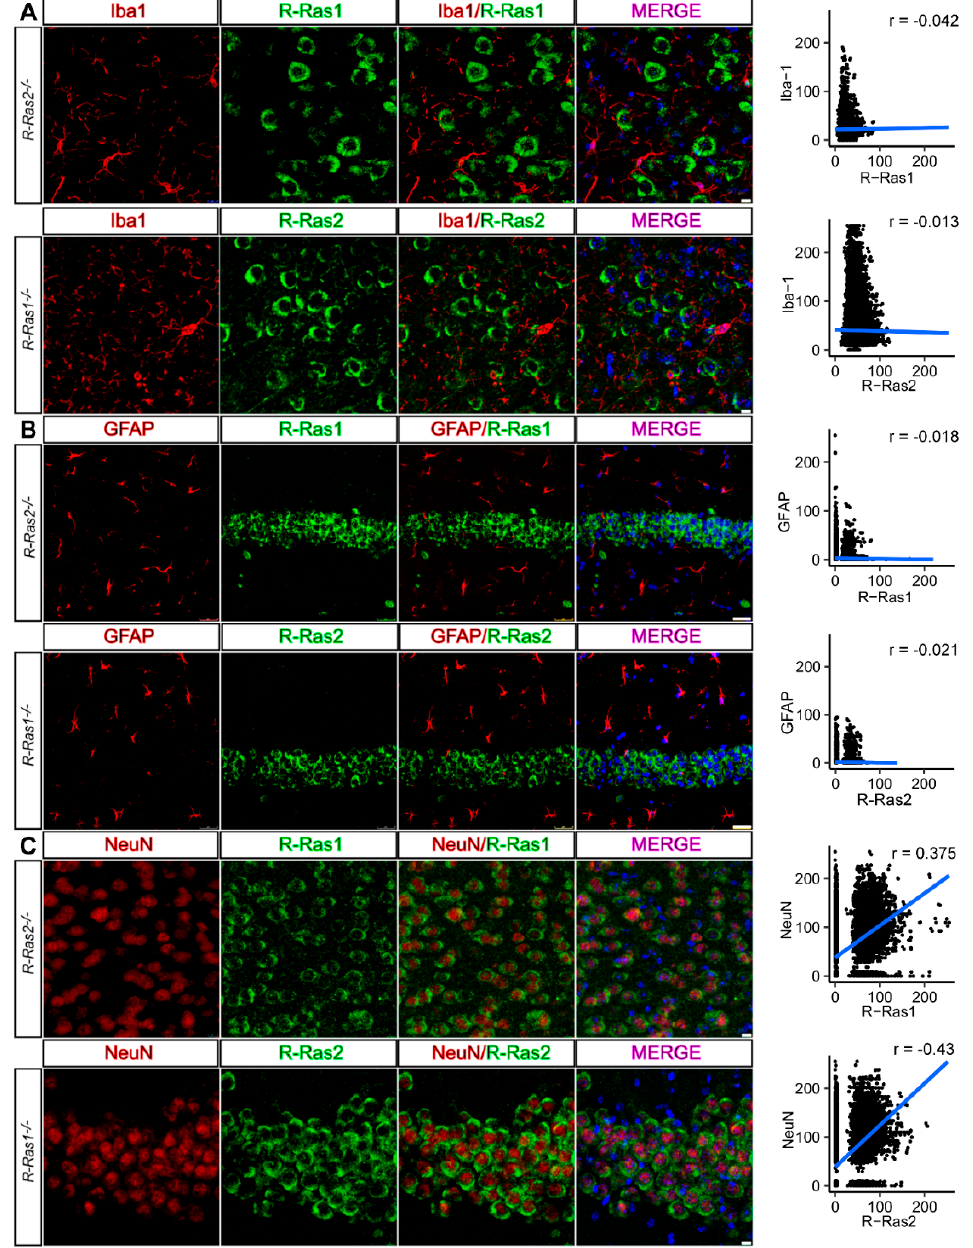
Figure 3. R-Ras1 and R-Ras2 are expressed in neurons, but not in astrocytes or microglia. ( A ) Double immunostaining of coronal sections from R-Ras1 − / − and R-Ras2 − / − adult mice (P90) with antibodies against R-Ras1 or R-Ras2 and the microglial marker Iba1 showed absence of colocalization between both markers. ( B ) Double immunostaining of coronal sections from R-Ras1 − / − and R-Ras2 − / − adult mice (P90) with antibodies against R-Ras1 or R-Ras2 and the astrocyte marker GFAP; neither GTPase colocalized with the GFAP marker. ( C ) Double immunostaining of coronal sections from R-Ras1 − / − and R-Ras2 − / − adult mice (P90) with antibodies against R-Ras1 or R-Ras2 and the neural marker NeuN; both GTPases localized with the NeuN marker within the same cell, indicating that R-Ras1 and R-Ras2 are expressed in neurons. Areas analyzed: dentate gyrus of the hippocampus (ML: 0.5 mm, AP: − 2 mm from bregma, DV: 2.2 mm) and upper layers of the somatosensory cortex (ML: 3 mm, AP: − 2 mm from bregma, DV: 1.5 mm). Pearson’s r correlation test was used for the statistical analysis. Fluorograms indicate the distribution of pixel intensity values for each marker used. Values